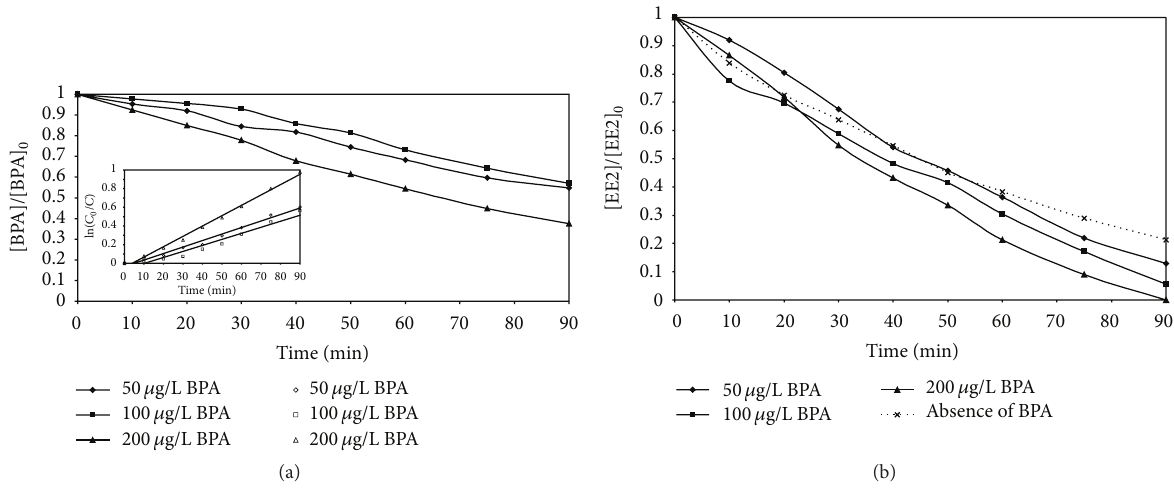
Figure 10: Degradation of a mixture of BPA and EE2 in UPW at 1.6mg/cm 2 ZnO. Effect of (a) 100 𝜇 g/L EE2 on 50, 100 and 200 𝜇 g/L BPA; (b) 50, 100 and 200 𝜇 g/L BPA on 100 𝜇 g/L EE2. Inset graph: plot of (3).